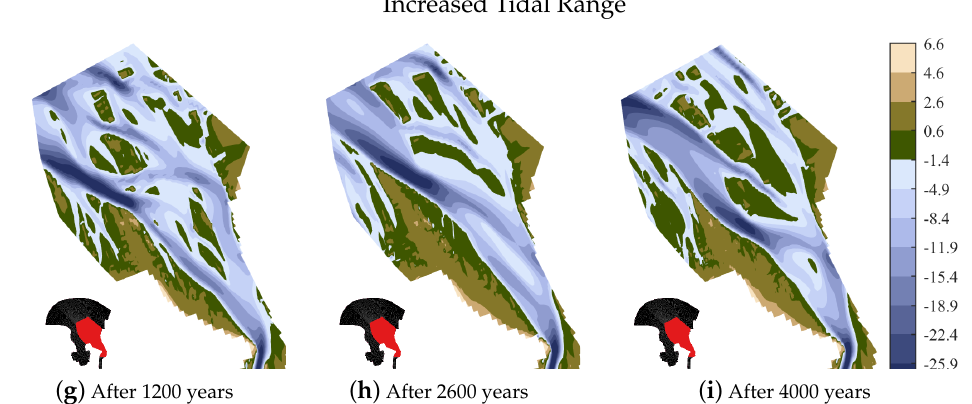
Figure A1. Results of the tidal scenario simulations at three different times in years (hydrodynamic time times the morphological factor). The first time-step is selected based on equilibrium conditions. Clear distinction between the channel (blue colors) and shoal (earth colors).